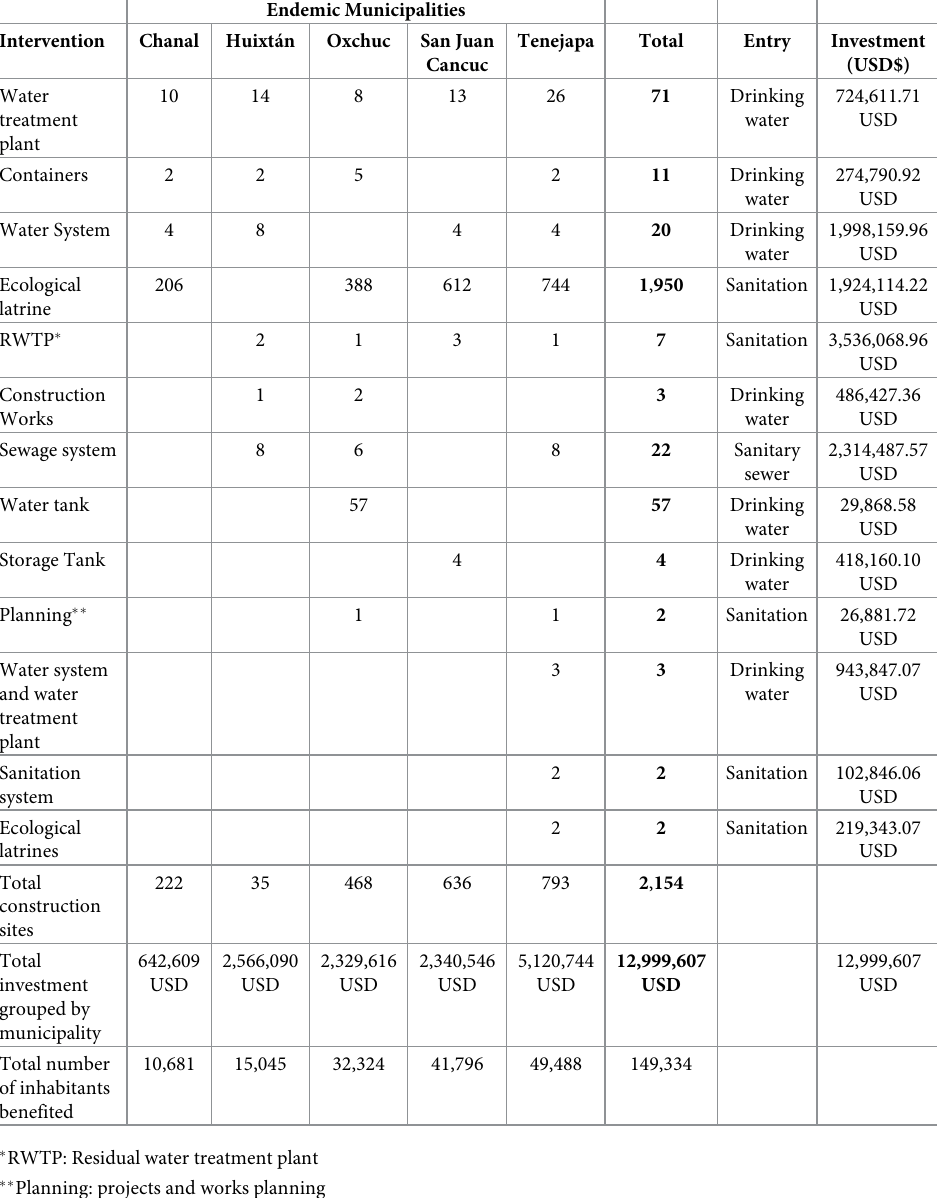
Table 2. Investment in basic water and sanitation in trachoma endemic municipalities, Chiapas State, 2006–2012. Source: Sustainable Plan for Hydraulic Works, Sanitation and Responsible Treatment of Solid Waste. Government of the State of Chiapas.